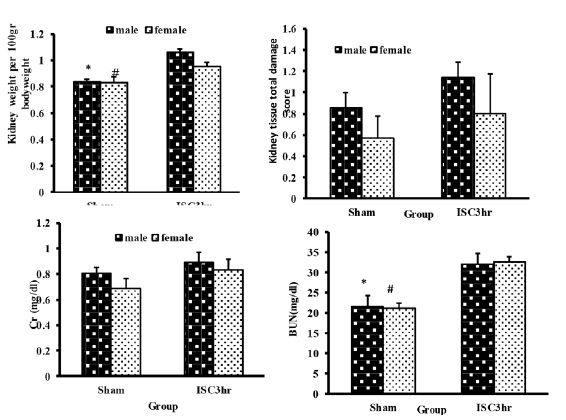
Figure 1. Comparison of Kidney Weight (KW), Kidney Tissue Damage Rate, Blood Urea Nitrogen Level (BUN) and Creatinine (Cr) in Both Male and Female Groups During Ischemia-reperfusion. * and # indicate a significant difference ( P < 0.05) between sham and ischemia in both male and female rats, respectively. Data were reported as mean ± SEM. P values were derived from one-way ANOVA and Kruskal-Wallis tests.